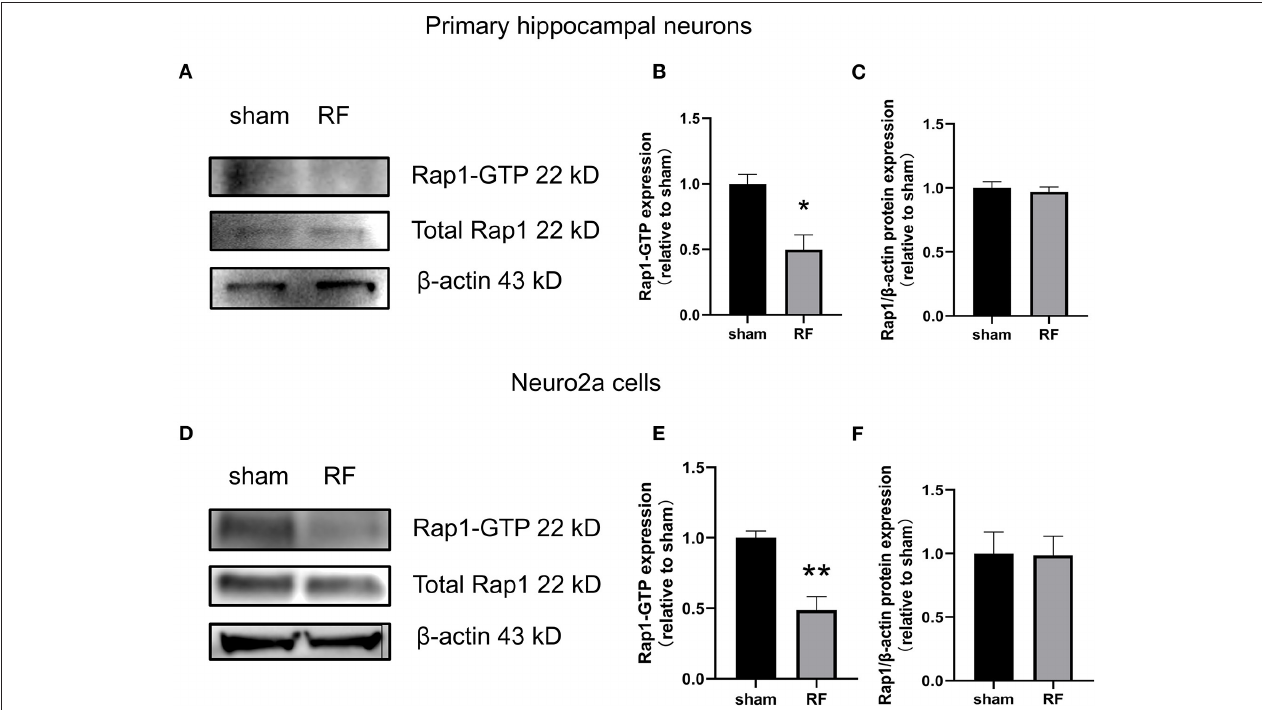
FIGURE 5 | Effects of RF-EMR exposure on Rap1-GTP protein expression in neuronal cells. Neuronal cells were exposed to 4 W/kg RF-EMR for 48h. The protein expression of Rap1-GTP protein in primary hippocampal neurons (A–C) and Neuro2a cells (D–F) is shown. Protein expression was analyzed by immunoprecipitation and western blot analysis. * P < 0.05, ** P < 0.01, Student’s t